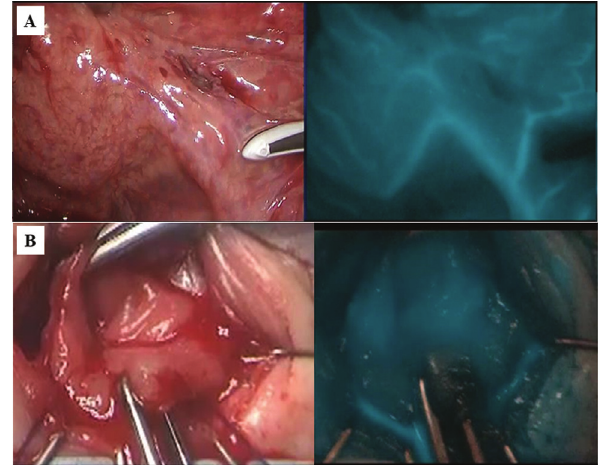
Fig. 2 ( A ) Mesenteric blood fl ow assessment. The mesentery blood fl ow in the pulled-through sigmoid colon was con fi rmed with indoc- yanine green (ICG) fl uorescence. ( B ) Evaluation of blood fl ow in the anastomotic sigmoid stump. Suf fi cient blood supply in the pulled through sigmoid colon was con fi rmed with ICG fl